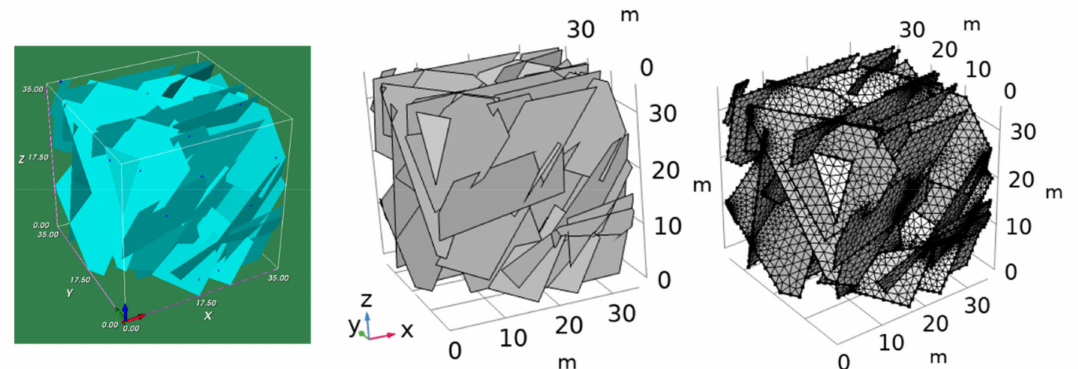
Figure 3. A DFN model generated in FracSim3D and re-produced and meshed in COMSOL. Fracture centres are generated within a 35 × 35 × 35 m cubic block and fractures are cropped by this